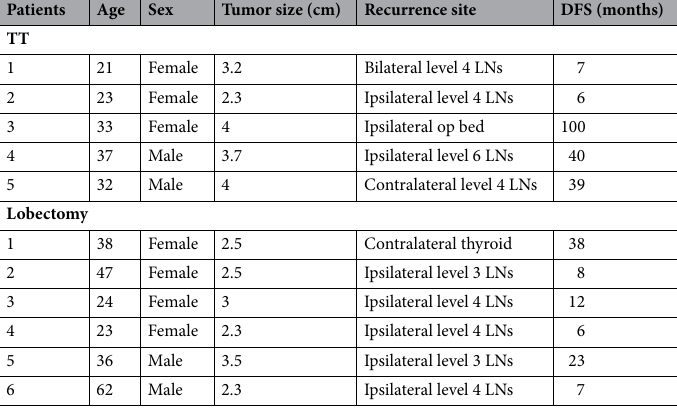
Table 6. Recurrence patterns of the study population. All patients who underwent BTT received radioactive iodine ablation therapy. DFS disease-free survival, TT total thyroidectomy, LN lymph node.